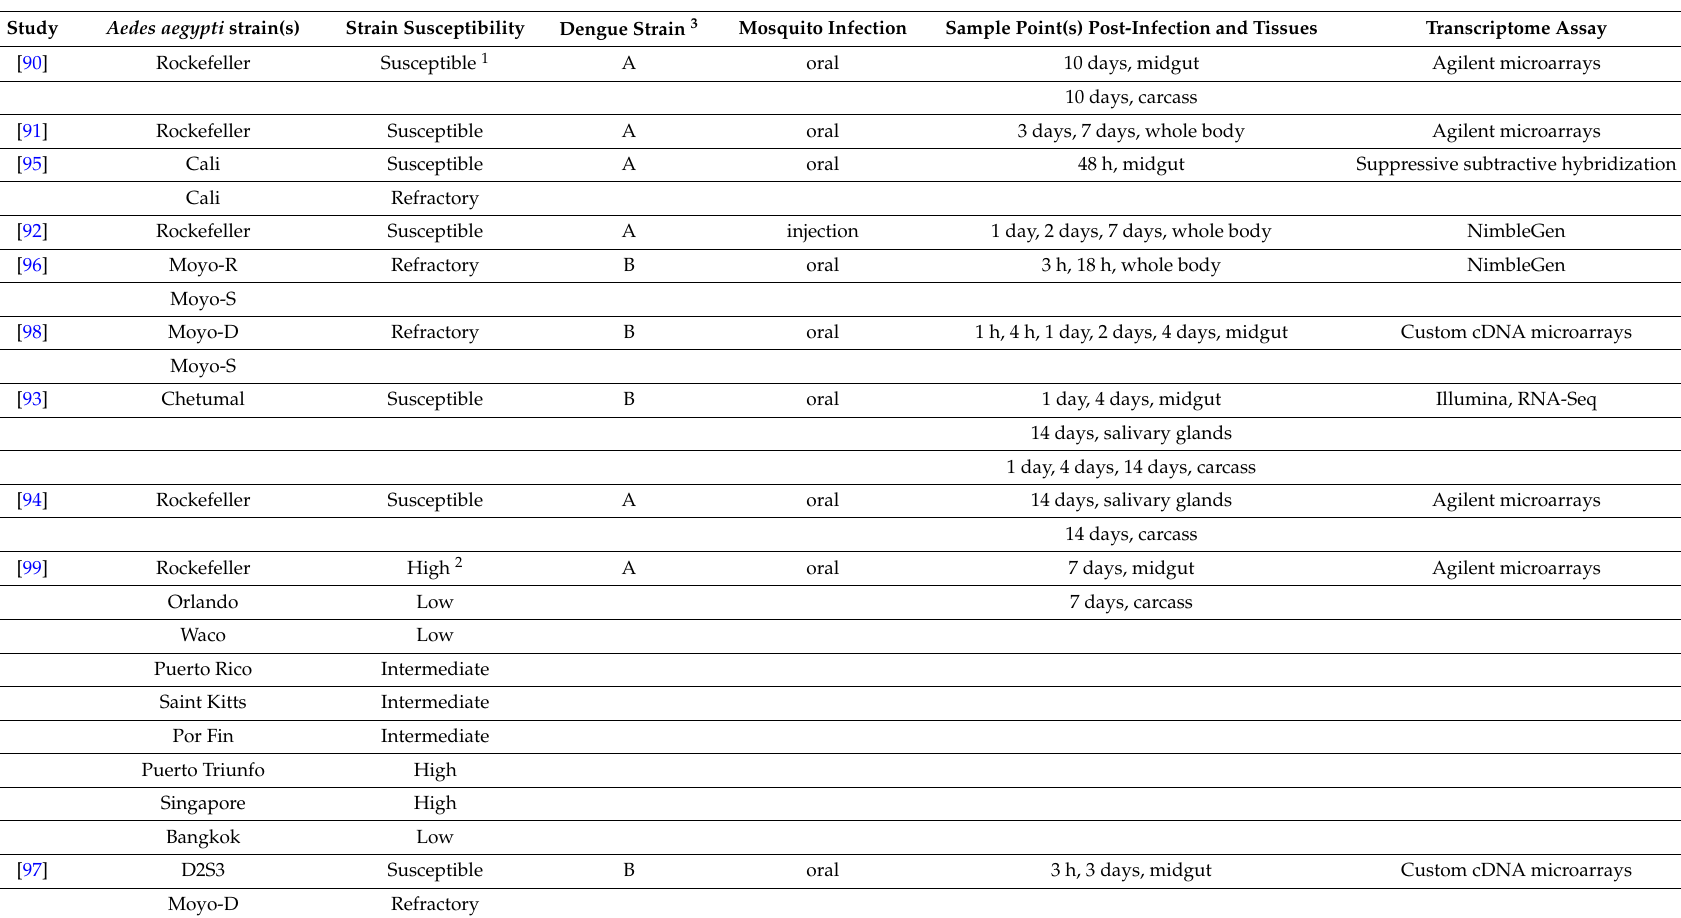
Table 1. Broad-scale transcriptome assays of the innate immune response of Aedes aegypti to dengue virus